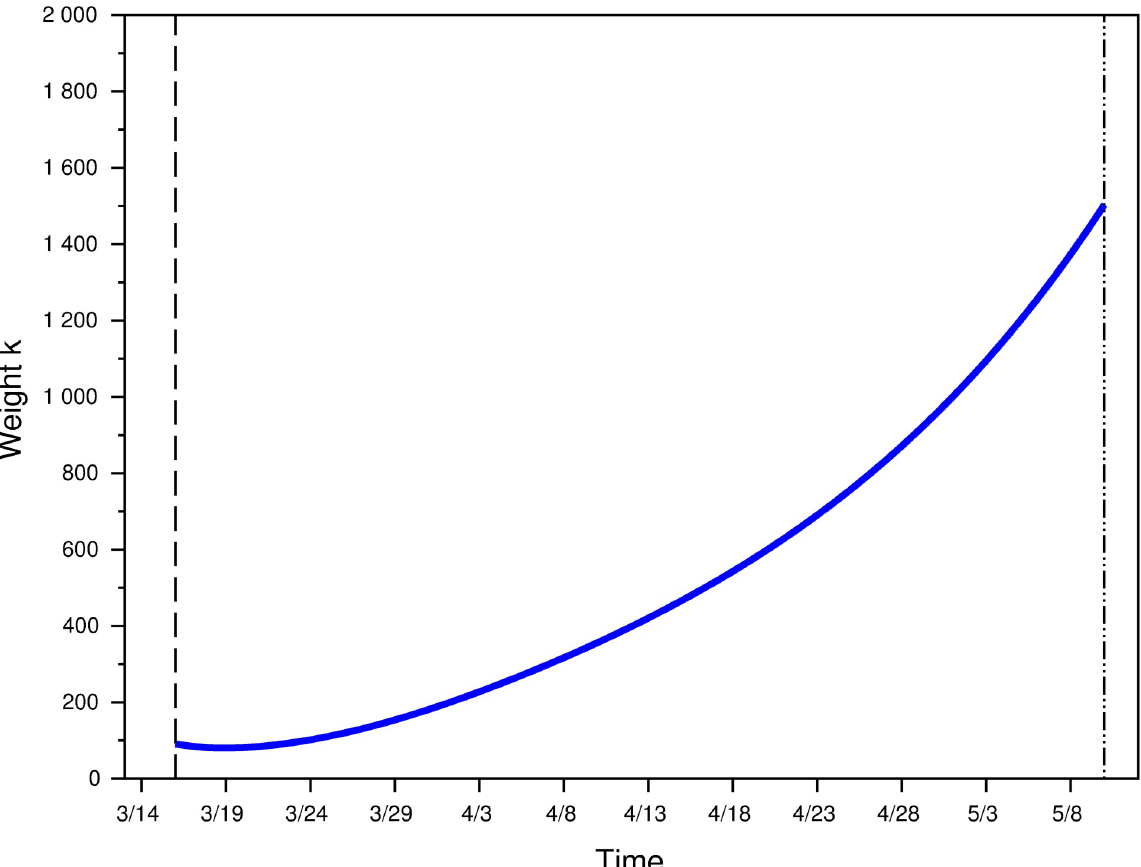
Fig 3. Computed value of weight k during the lockdown period [ t 1 , t 2